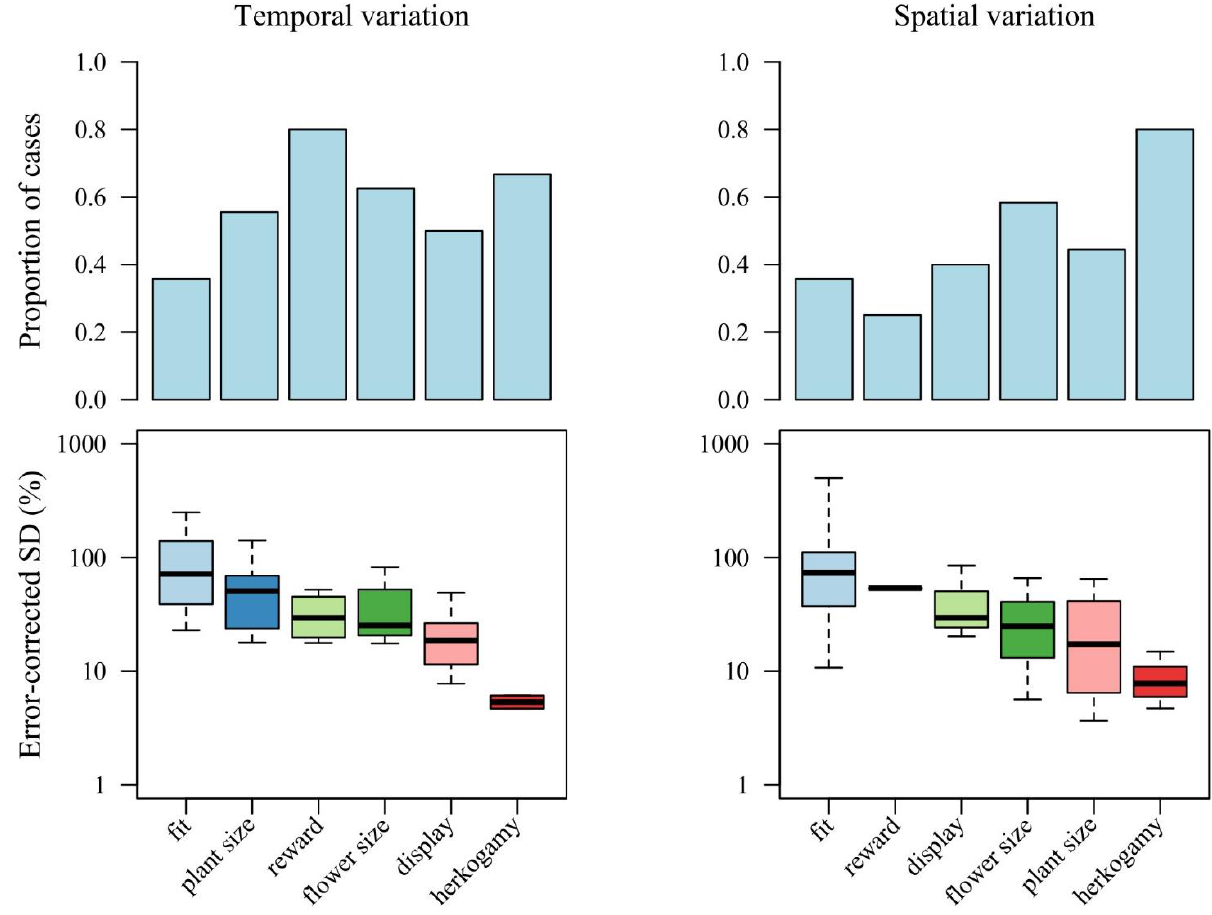
Figure 3. Patterns of temporal (among years for a site) and spatial (among sites within a year) variation in phenotypic selection on pollination traits. The barplots indicate the proportion of cases where variation in selection remain after accounting for sampling variance, and the boxplots give the distribution of error-corrected standard deviations of selection gradients for those cases where variation was detected. The error-corrected standard deviations can be interpreted as the average difference in selection among years (for temporal variation) or sites (for spatial variation). A mean-standardized selection gradient of 100% means that selection is as strong as selection on fitness as a